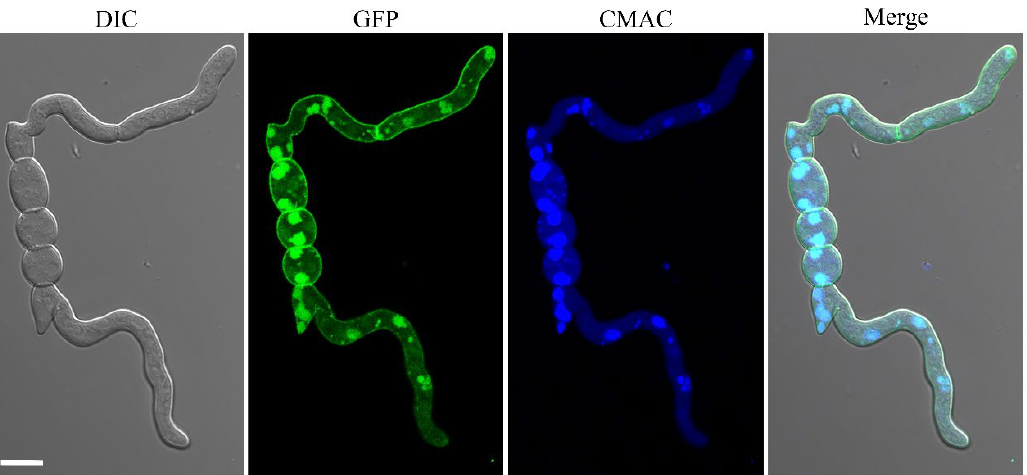
Figure 8. Subcellular localization of GFP-FgYck1. Hyphae of PH-1/GFP- FgYCK1 transformant from 12-h-old YEPD cultures were examined by confocal microscopy. The GFP signals mainly localized to plasma membrane and vacuolar lumen. The CMAC dye was used to stain the vacuolar lumen. Bar, 10 μm.